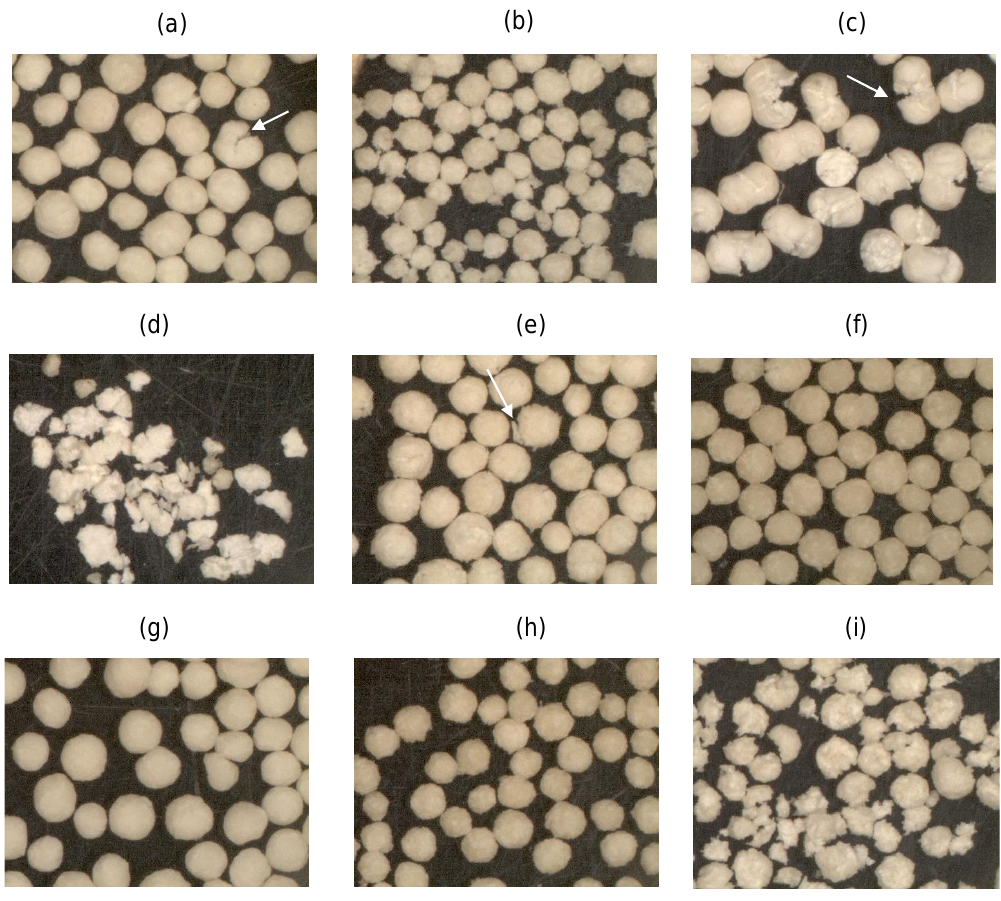
Figure 10. Images of pellets from all experimental batches ( a – i ) (Table 1) collected and dried after dissolution testing at pH 5.6 (Arrows indicate areas of disruption)